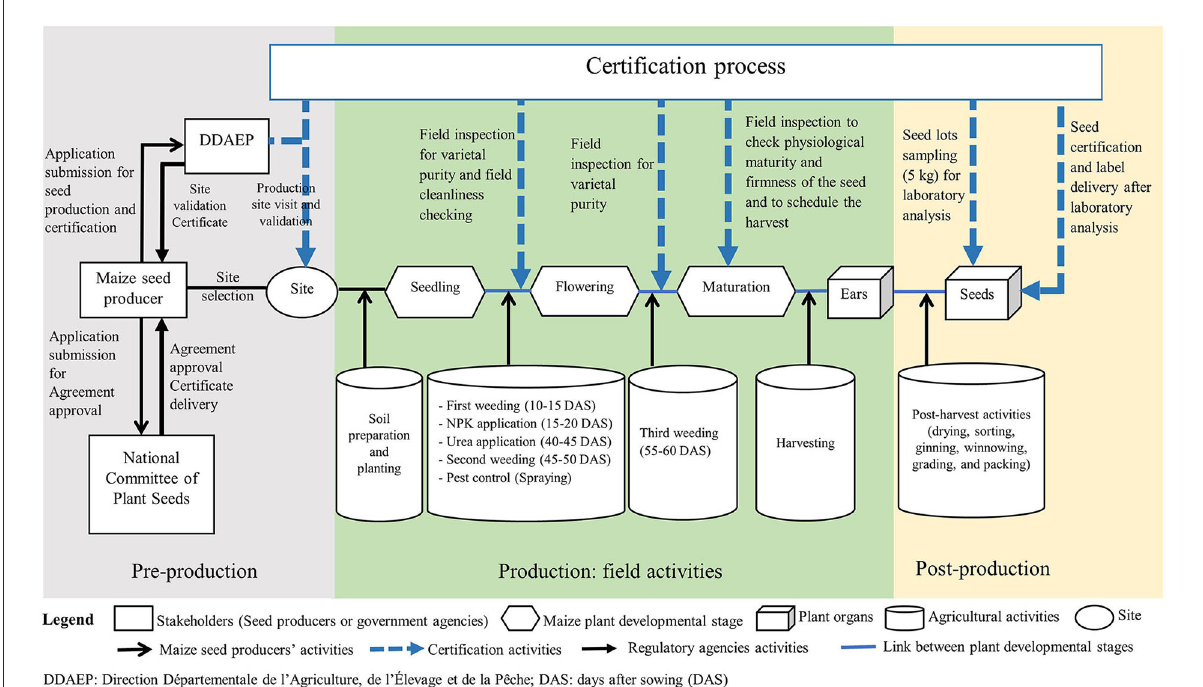
FIGURE4 Maize seed production practices and certification process in Benin.